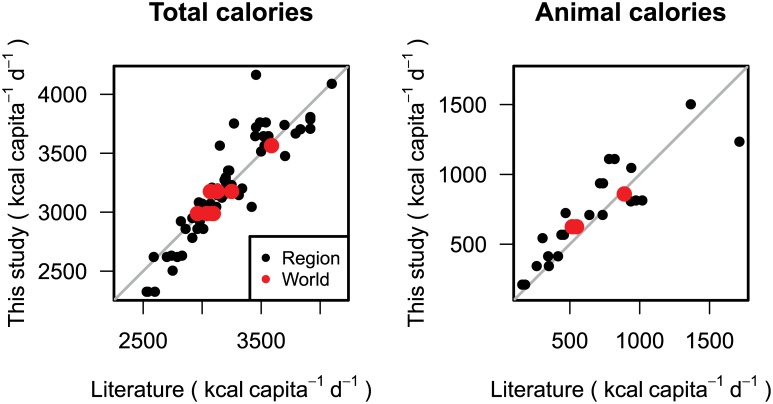
Comparison of estimates of total (left) and animal-based (right) calorie demand between values from the literature [17, 19–21] (x-axis) and own calculations (y-axis). Values are given for 2030 and 2050 as regional means (black dots) which are derived as population weighted averages of countries in the same regions as given in the literature and global means (red dots). Compare Tables (9, 10 and 11) and discussion in section on “Comparison of calorie demand projections to other studies”.